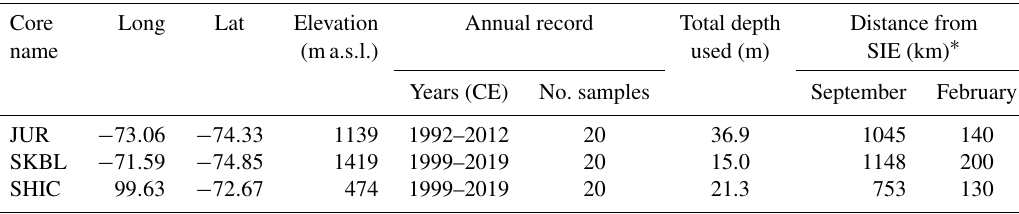
Table 1. Summary of each ice core geographical location and main features analysed in this study. SIE: sea ice edge ( ∗ ) – the distance from SIE reported corresponds to the median for years covering the data interval. September SIE values used for calculations were obtained as the distance between the ice core site and the closest point in the northern limit of 15% sea ice cover. February SIE values used for calculations were obtained as the distance between the ice core site and the closest sea-ice-free